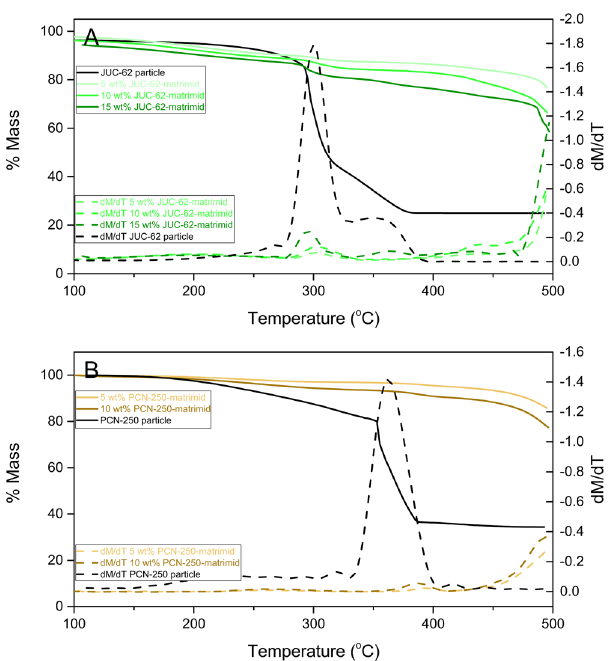
Figure 3. TGA data analysis of JUC-62 ( A ) and PCN-250 ( B ) matrimid mixed matrix